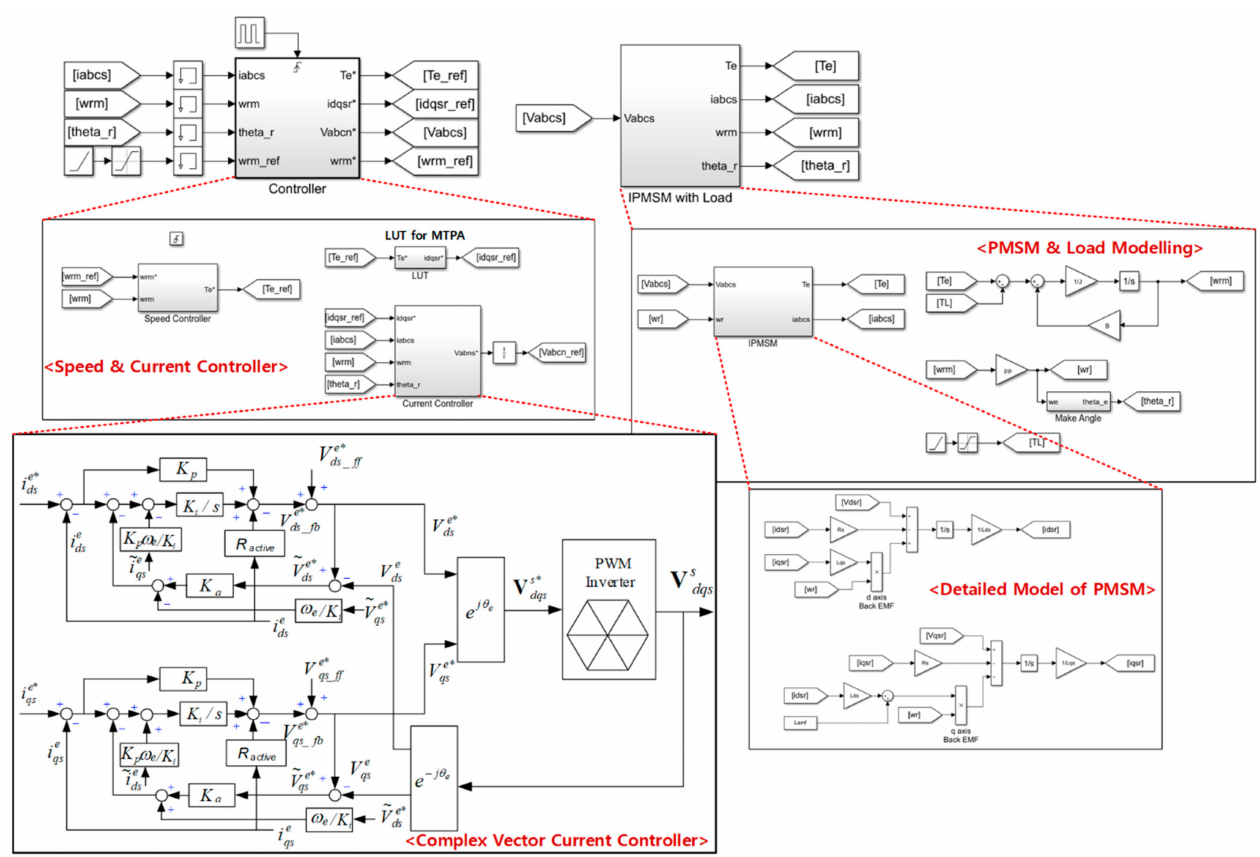
Figure 4. Simulation of the propulsion motor.